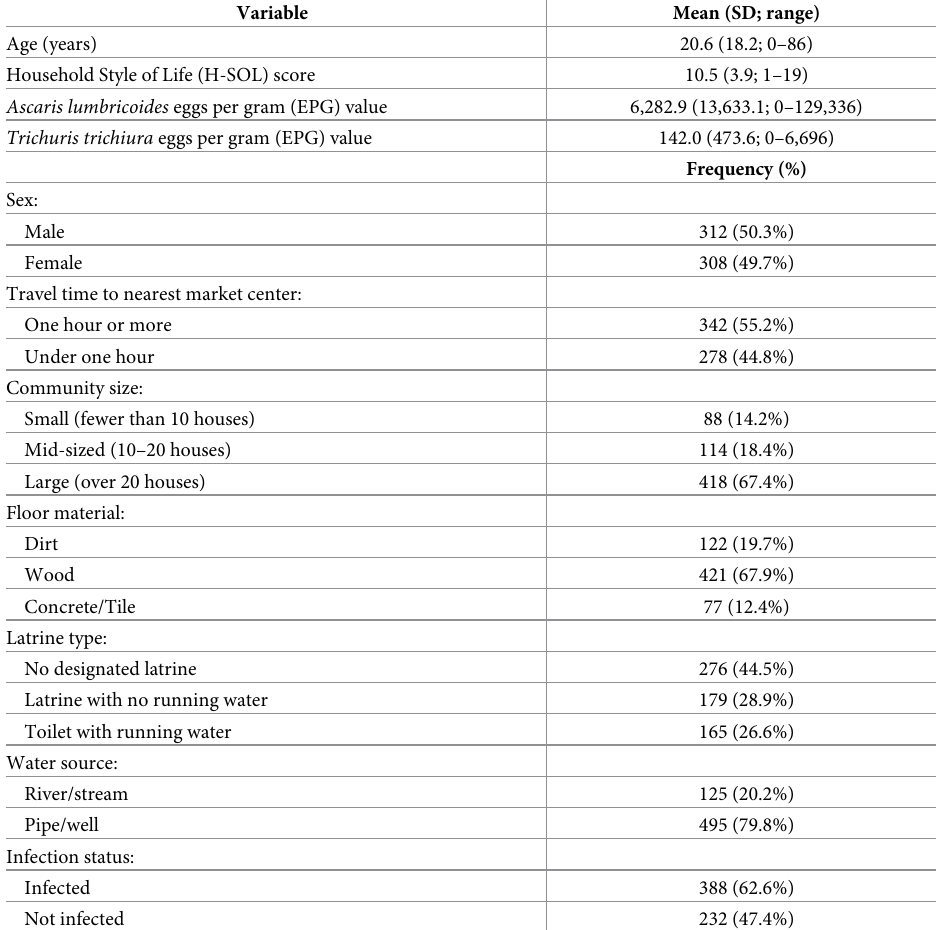
Table 2. Descriptive statistics of model